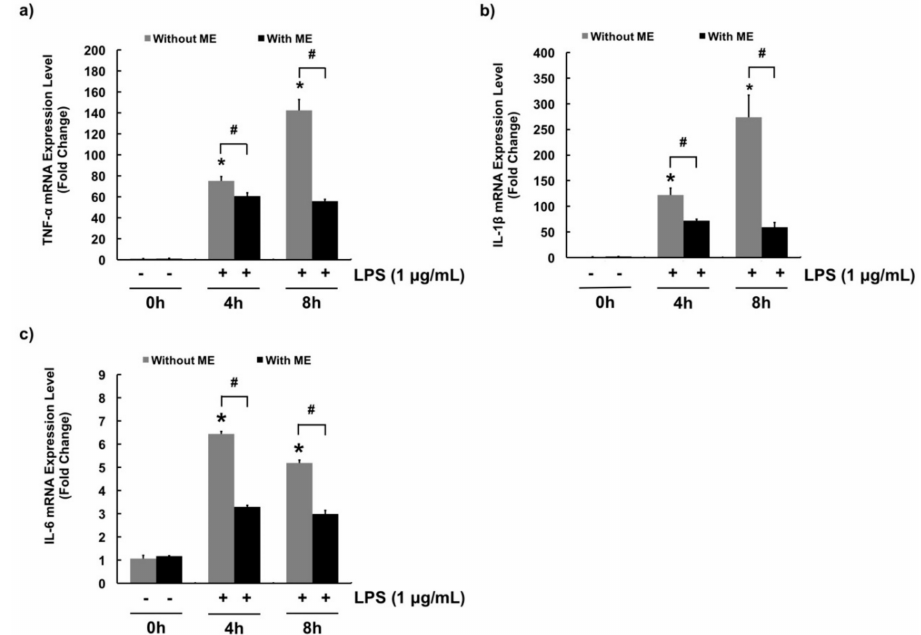
Figure 4. mRNA expression levels of pro-inflammatory cytokines in cells treated with moringa extract (ME). Gene expression levels of pro-inflammatory cytokines ( a ) TNF- α , ( b ) IL-1 β , and ( c ) IL-6 were determined. Cells were pre-treated with or without ME (200 µ g / mL) for 12 h followed by LPS treatment (1 µ g / mL) for 0, 4, and 8 h. mRNA expression levels were measured using RT-PCR. mRNA expression levels were calculated relative to GAPDH expression. Values represent means ± SEM ( n = 3). *, significant di ff erence vs. control (no ME, no LPS) ( p < 0.05). #, significant di ff erence between the two treatment groups ( p <